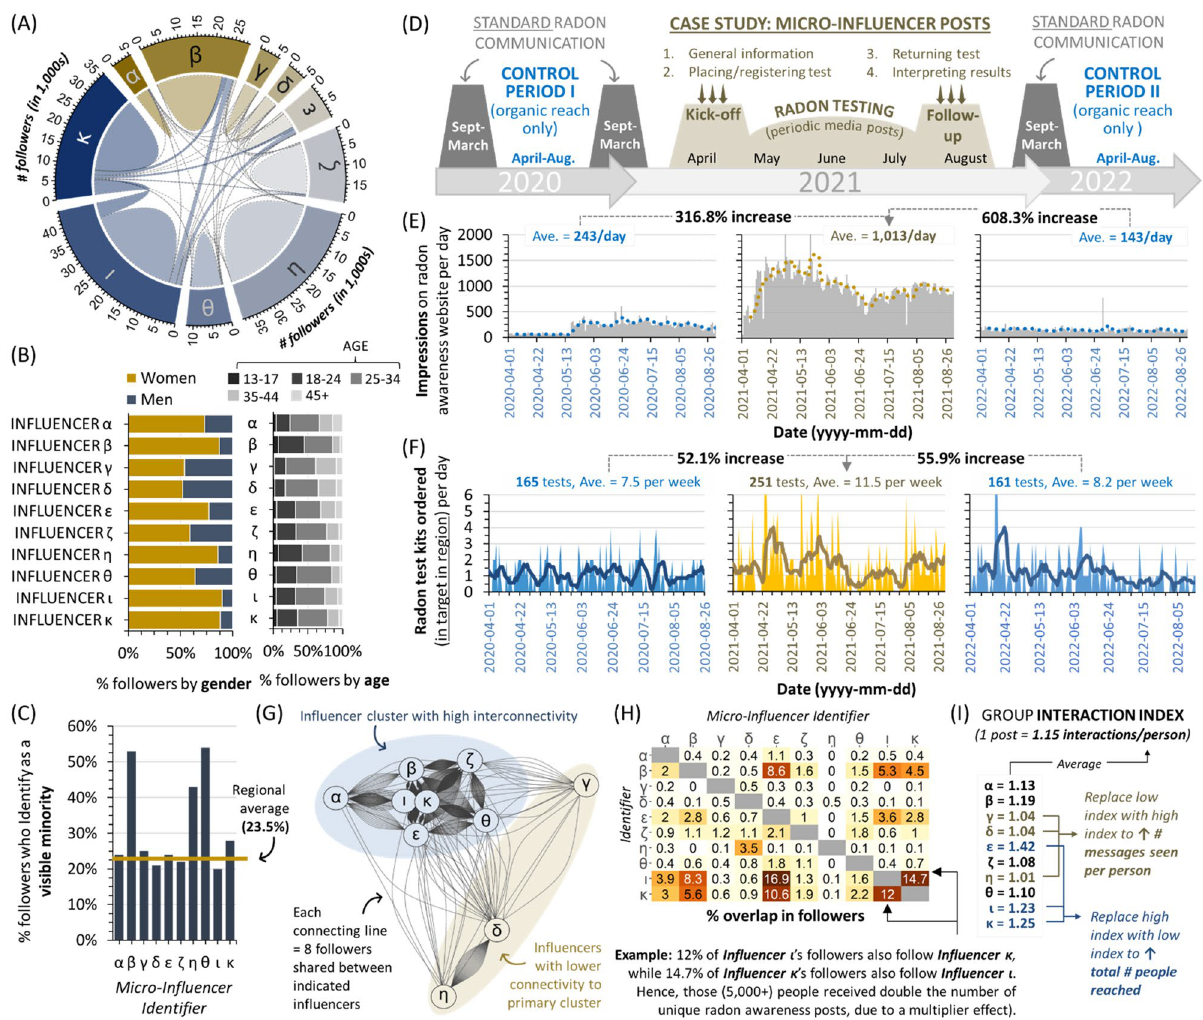
Figure 8. Microinfluencer based public health communication is effective at increasing health-seeking behaviour (radon-testing) amongst younger adults. Panel A . A chord diagram indicating the number of followers (in the 1000 s) per influencer designated by the indicated Greek letter identifiers, with lines between influencers indicating shared followers. Panel B . Per influencer from ( A ), the percent distribution of followers by age and gender identity. Panel C . Per influencer from ( A ), the percent of followers identifying as a visible minority. Pane D . Schematic of activity over the case study and control periods. Panel E . Radon awareness study website impressions per day across the control and case study periods. Panel F . Radon test kits obtained per day from the study and only from the target region, across the control and case study periods. Panel G . A network diagram showing relative interconnectivity between influencers. Each line connecting an influencer represents 8 total shared followers. Panel H . Matrix diagram showing the percent of shared followers for all pairwise combinations. Panel I . The overall interaction index (i.e., the number of interactions with radon awareness information received per follower, per social media post) for the group, based on each individual. Figures